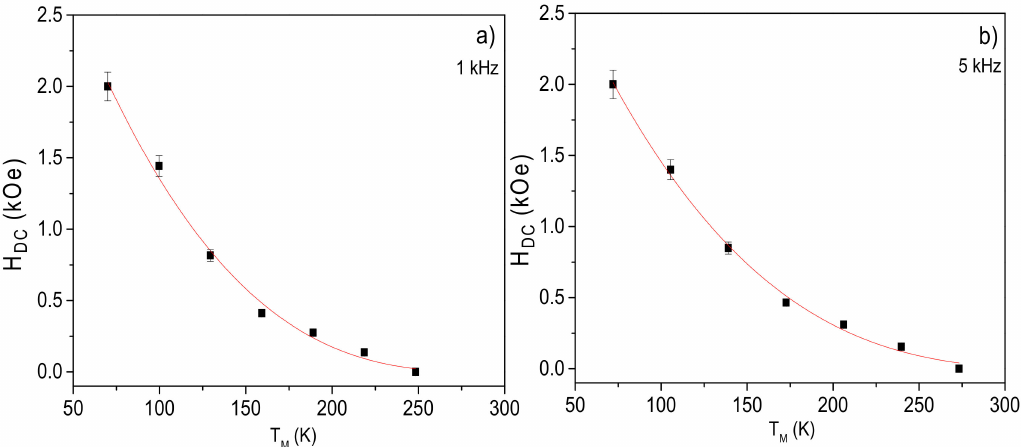
Figure 5. Almeida–Thouless (A–T) plots for 1 kHz ( a ) and 5 KHz ( b ). T M values were taken from the χ ”(T,f) component of the AC susceptibility curves under several DC field